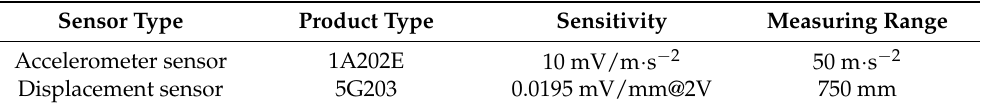
Table 2. Sensor Table 2. Sensor specifications.